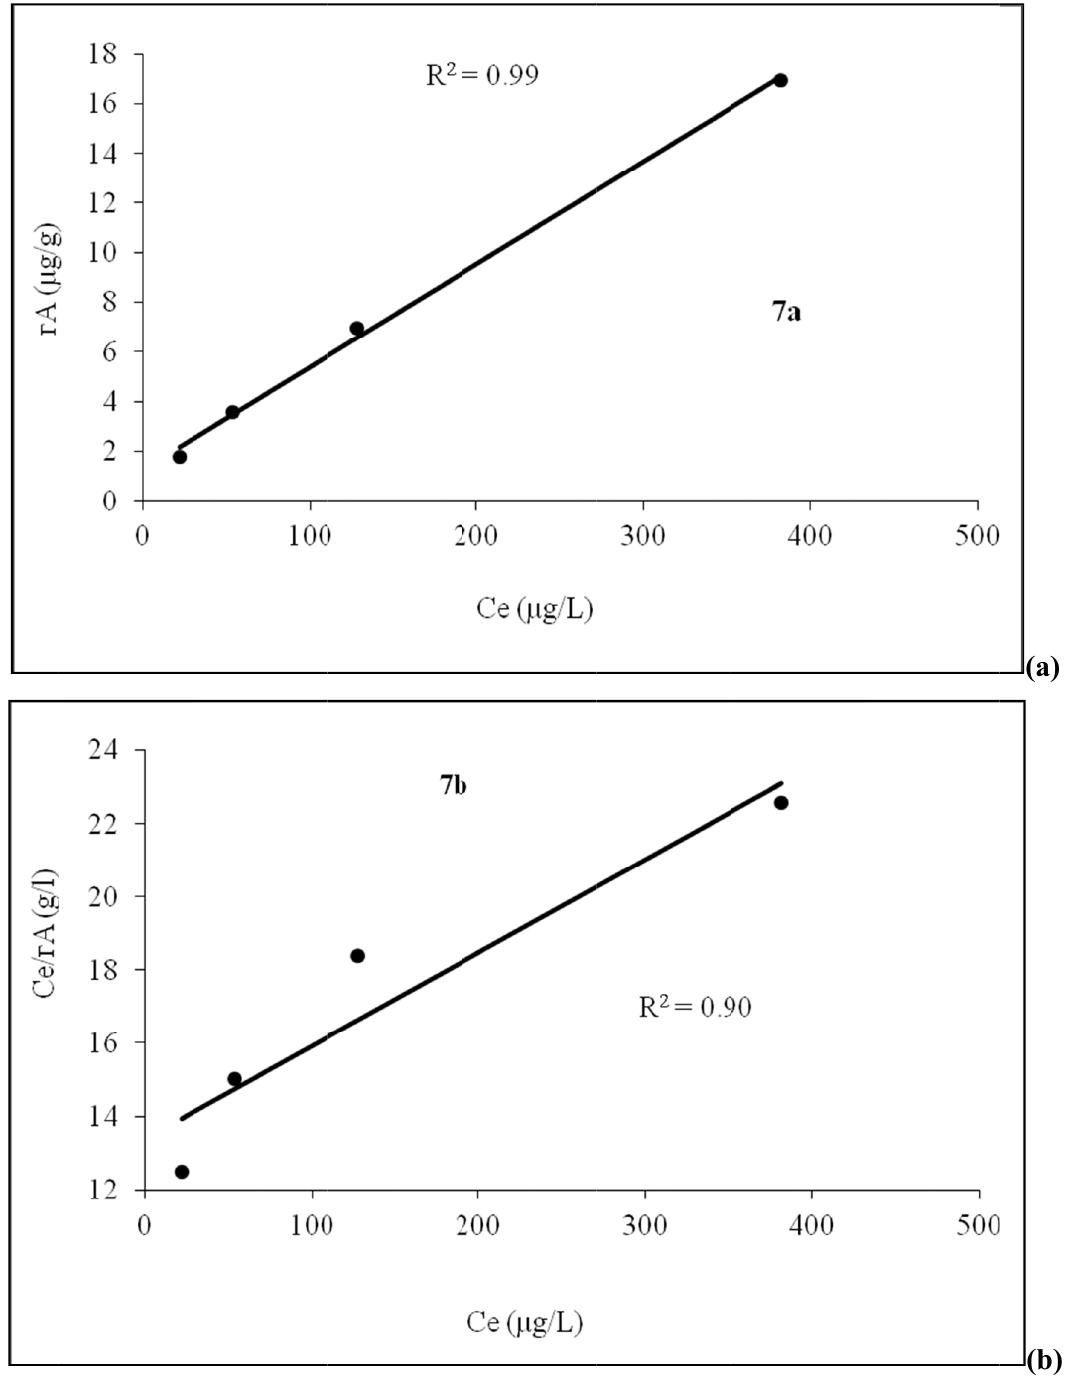
quation was elation with n